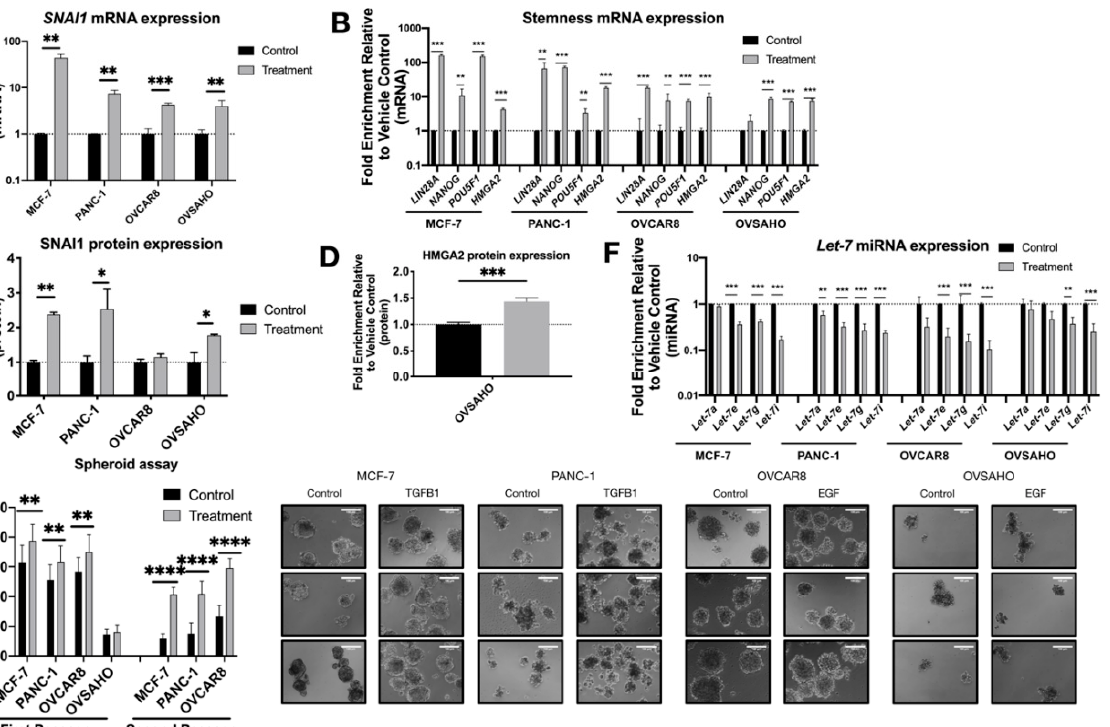
Figure 1. Growth factor treatment results in increased SNAI1, increased stemness and decreased let-7 expression. MCF-7, PANC-1 were treated with TGFB1; OVCAR8, OVSAHO were treated with EGF. Levels of control group (cells treated with vehicle control) were normalized to 1. Values for RT-qPCR are shown on a log scale. ( A , B ) RT-qPCR analysis for mRNA expression level of SNAI1 ( A ) and of stemness markers (( B ), LIN28A, NANOG, POU5F1 and HMGA2 ). ( C , D ) The quantification of Western blot analysis for protein expression of SNAI1 ( C ) and HMGA2 ( D ). ( E ) Left panel: The quantification of number of spheroids per 3000 cells (both first passage and second passage) is shown. Right panel: Phase contrast images of spheroids formed from cells (first passage) as indicated are presented. In each panel, the spheroids formed from control group are presented on the left, those from the treatment group are on the right. Scale bar = 100 µm ( F ) RT-qPCR analysis for let-7 miRNA ( let-7a , let-7e , let-7g and let-7i) expression. * p < 0.05; ** p < 0.01; *** p < 0.001; **** p < 0.0001.